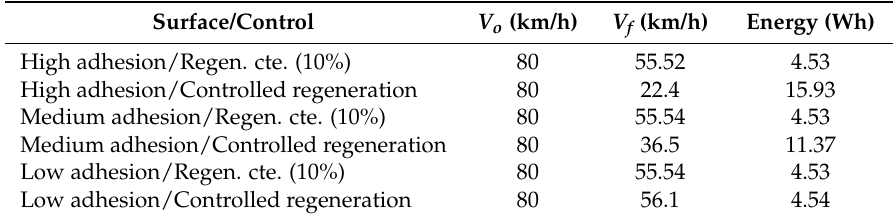
Table 4. Comparison of